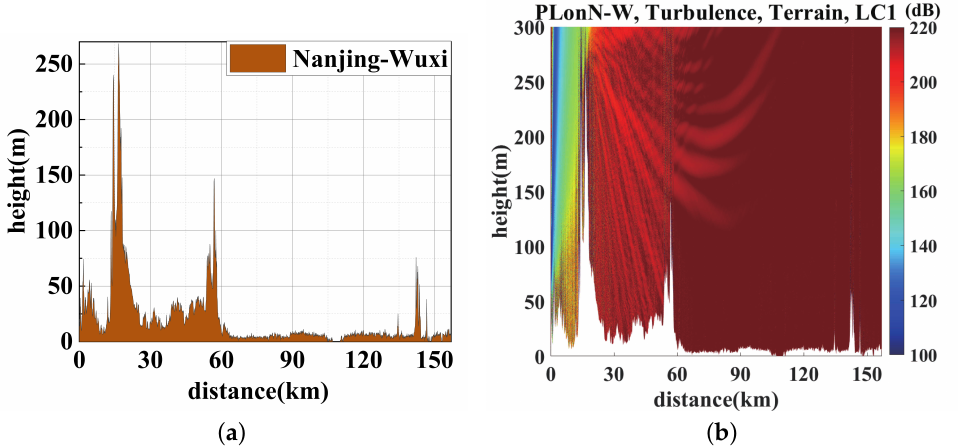
Figure 14. The ( a ) DEM and ( b ) propagation loss with tropospheric scattering, IGBP LC, and DEM were considered on Nanjing–Wuxi. ( a ) DEM from Nanjing to Wuxi. ( b ) Propagation Loss on